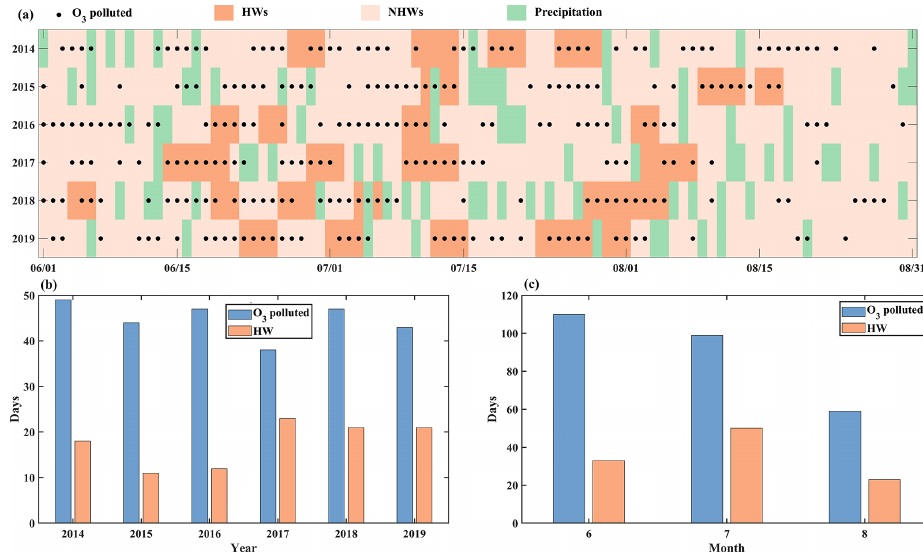
Figure 2. (a) Time series of synoptic weather types, in which the black dots indicate O 3 pollution that occurred on that day. Interannual (b) and intraseasonal (c) variations in summertime O 3 pollution and HW days.